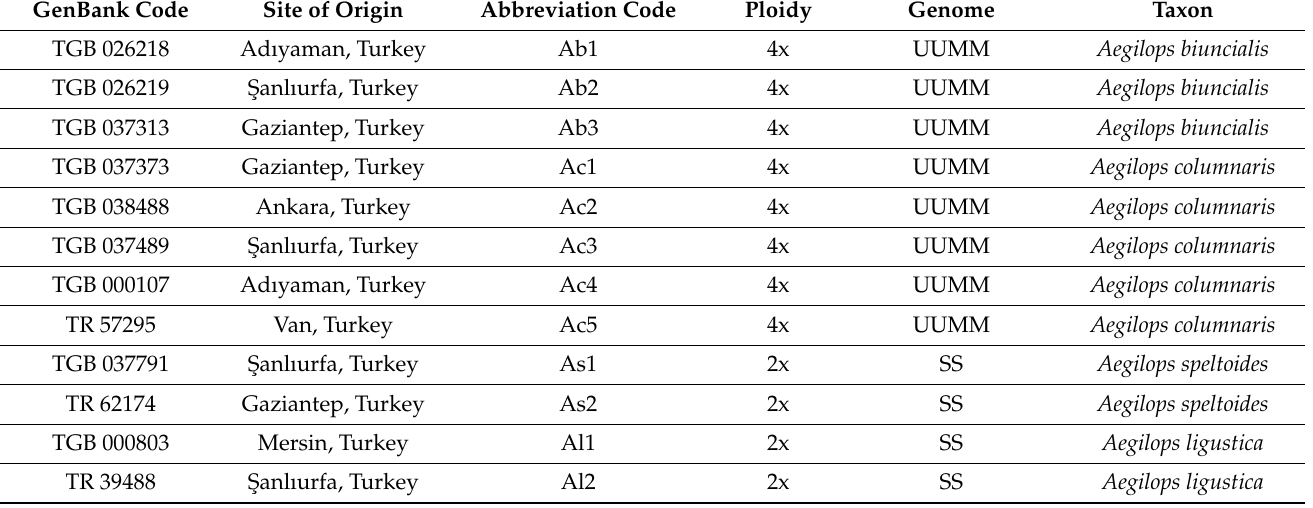
Table 1. Information of the 19 Aegilops genotypes and check hexaploid wheat cultivar, Bolal 2973 used in the